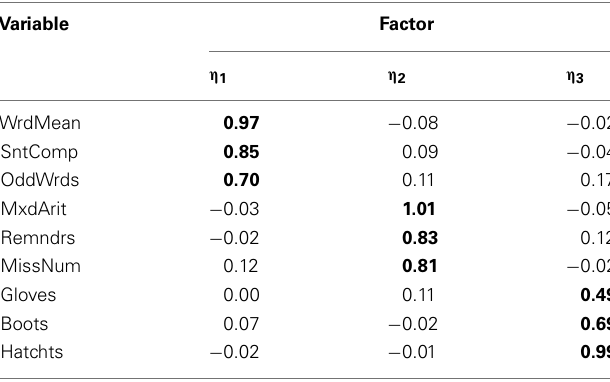
Table 17 |Three-factor model loading matrix obtained with EFA of polychoric R among Case 4 item-level